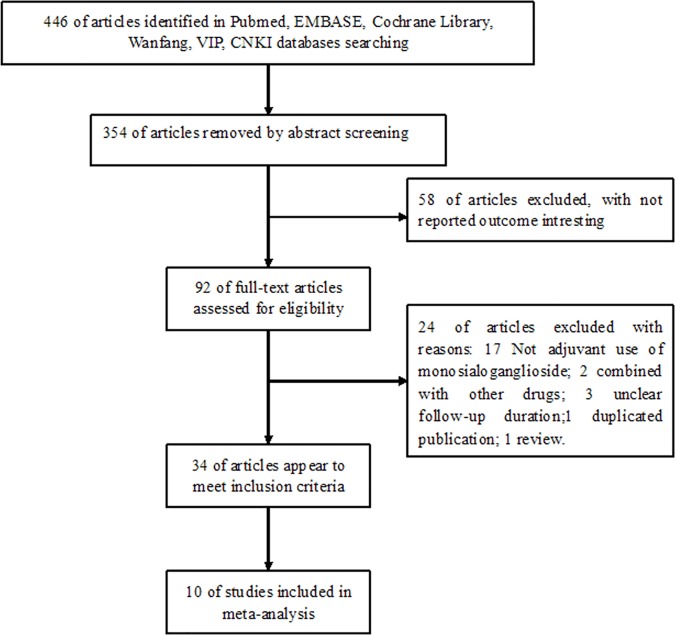
Flow chart of trial selection process.